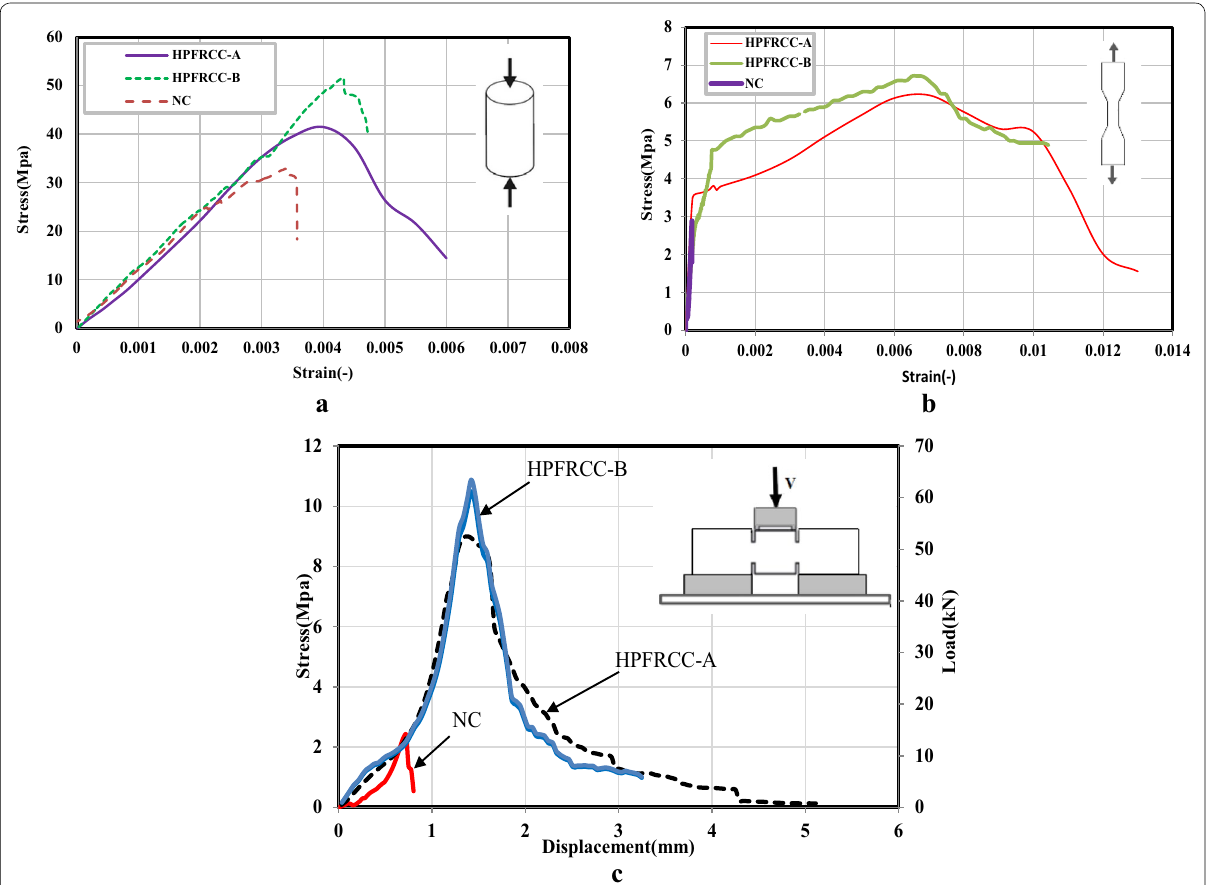
Fig. 16 Mechanical properties of specimens: a uniaxial compression stress–strain; b uniaxial tensile stress–strain; c direct shear test (responses of specimens).